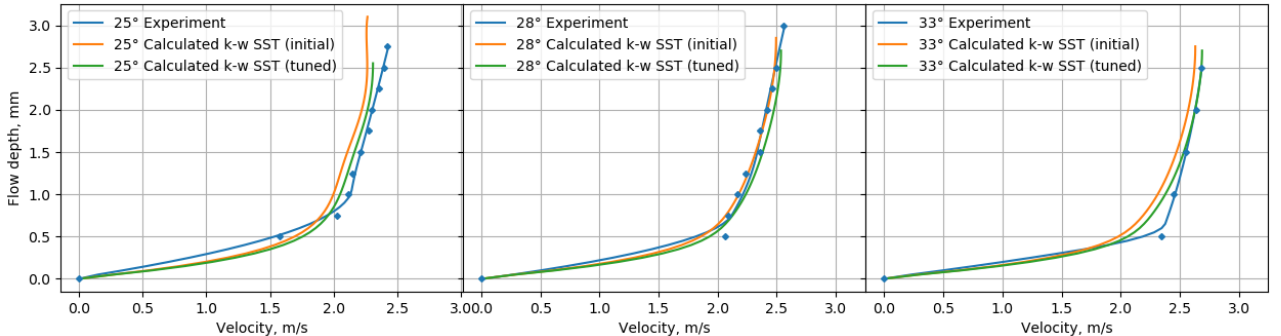
Figure 7. Comparison of velocity profiles calculated by the k - ω SST model using initial and tuned coefficients with the experimental profile at different chute inclination angles.